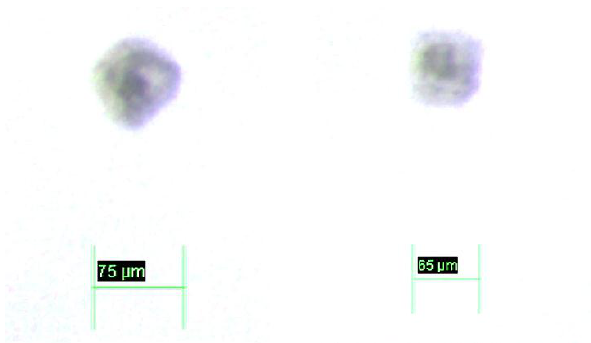
Figure 7. Detailed view of the patterns micro milled in the inner faces of the quartz cuvette.